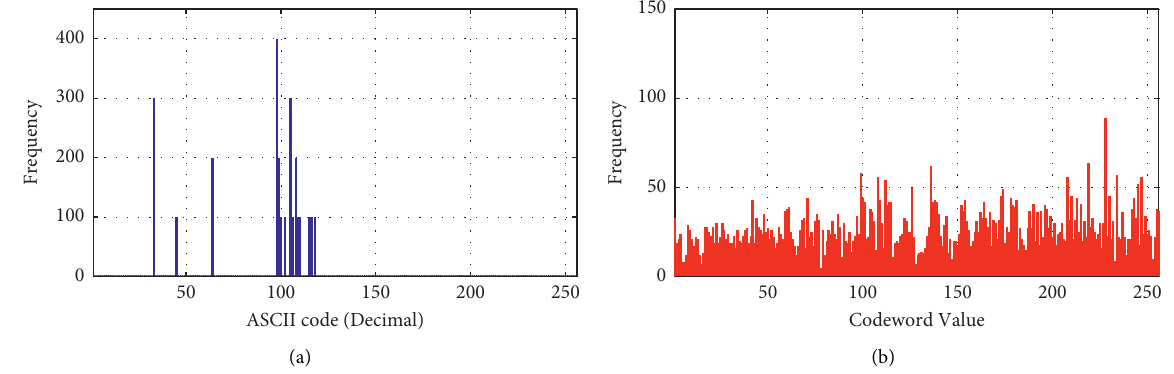
Figure 16: Histogram distribution graph of (a) the plaintext and (b) transmitted data. Table 2: Comparison between the proposed secure data transmission scheme and the other works. Scheme Application of chaos Probabilistic Data type